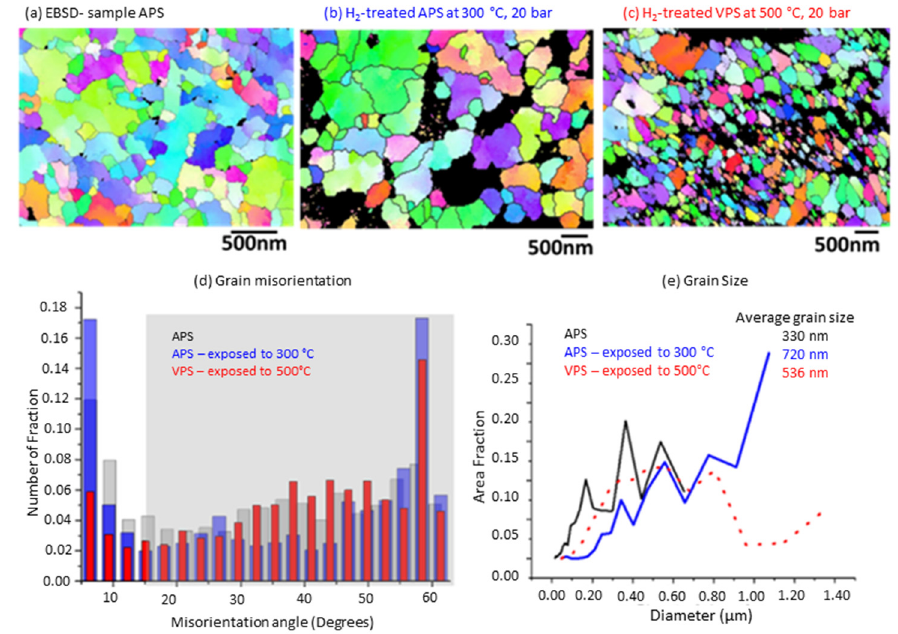
Figure 9. EBSD mapping of the samples: ( a ) as prepared after SPS-APS, ( b ) the SPS-APS sample heated at 300 °C, 20 bar of hydrogen for 72 hr, ( c ) VPS samples exposed at 500 °C, 1 bar of hydrogen atmosphere, ( d ) misorientation angle between the grains, ( e ) the grain size distribution analysis from the respective EBSD map.